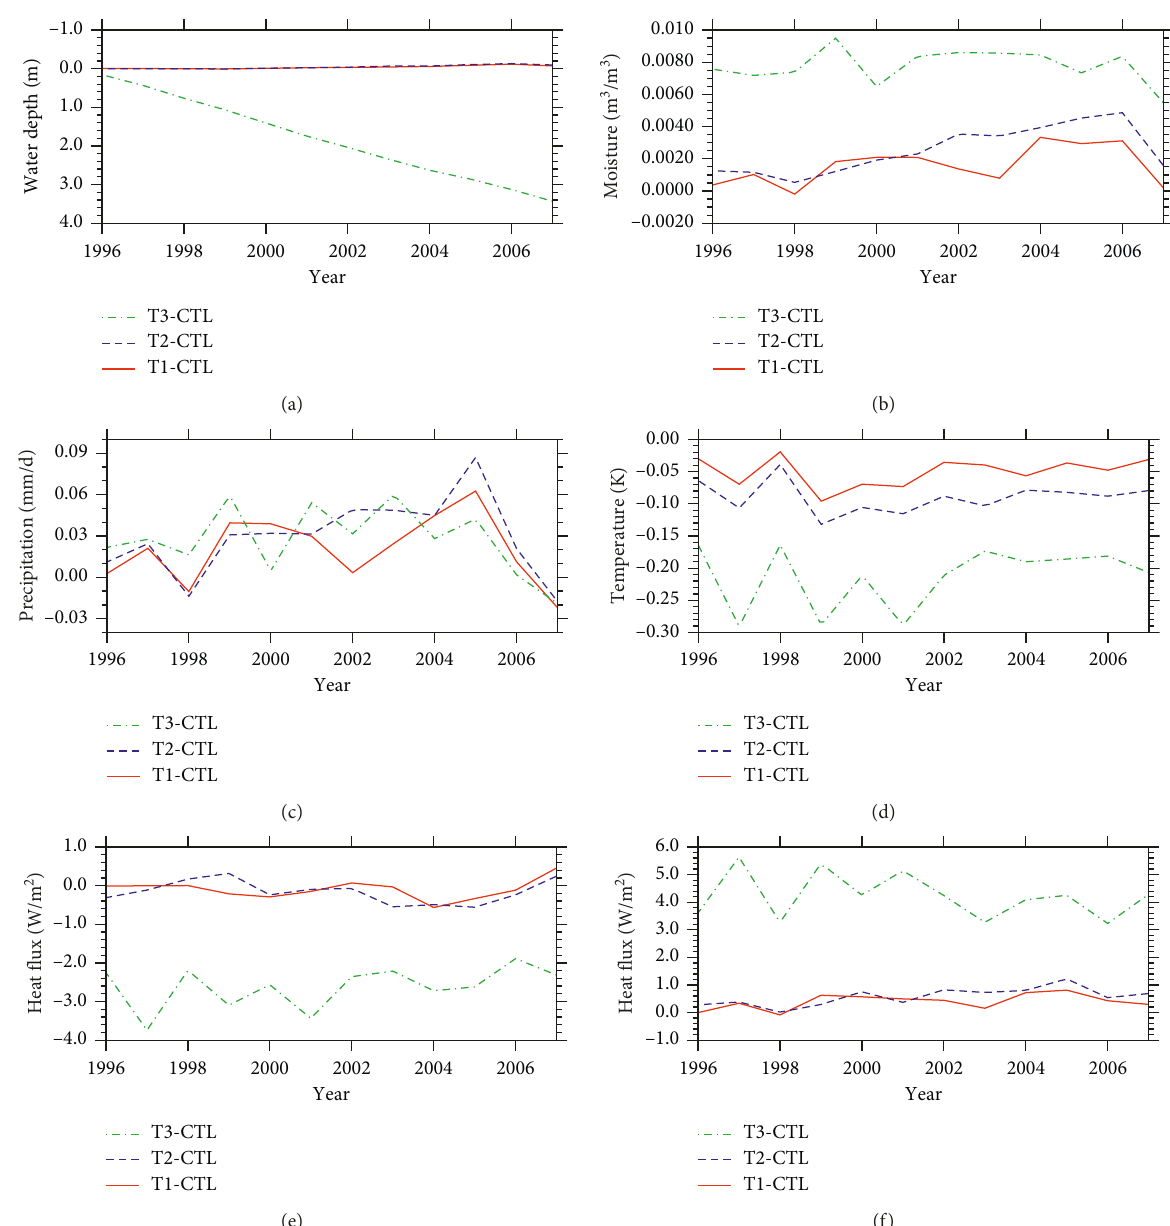
Figure 9: Annual series of (a) groundwater depth differences, (b) soil moisture differences at 10cm depth, (c) precipitation differences,